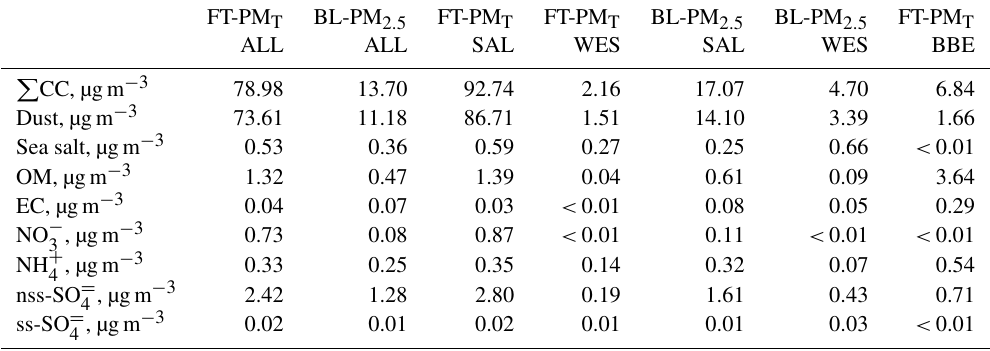
Table 1. Average concentration of the chemical major compounds for (i) FT-PM T and BL-PM 2 . 5 taking into account all samples, (ii) FT-PM T and BL-PM 2 . 5 collected within the Saharan Air Layer (SAL), (iii) FT-PM T and BL-PM 2 . 5 collected within the westerlies (WES) without the FT-PM T biomass burning event and (iv) FT-PM T biomass burning event